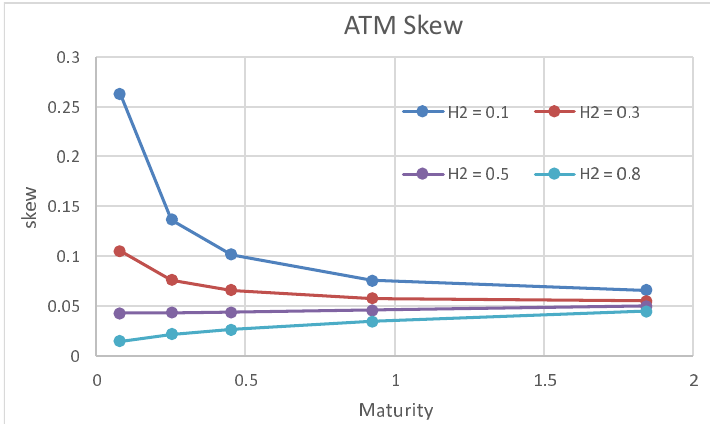
Figure 2. ATM skew with respect to H 2 , where H 2 denotes the Hurst index of the rough volatility. The model parameters are listed in Table